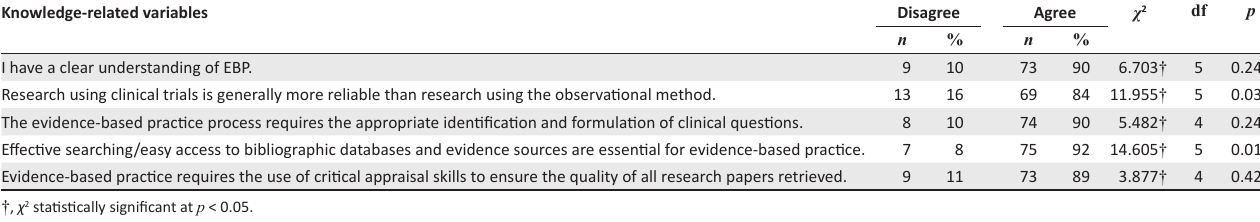
TABLE 1: Knowledge of evidence-based practice. Knowledge-related variables